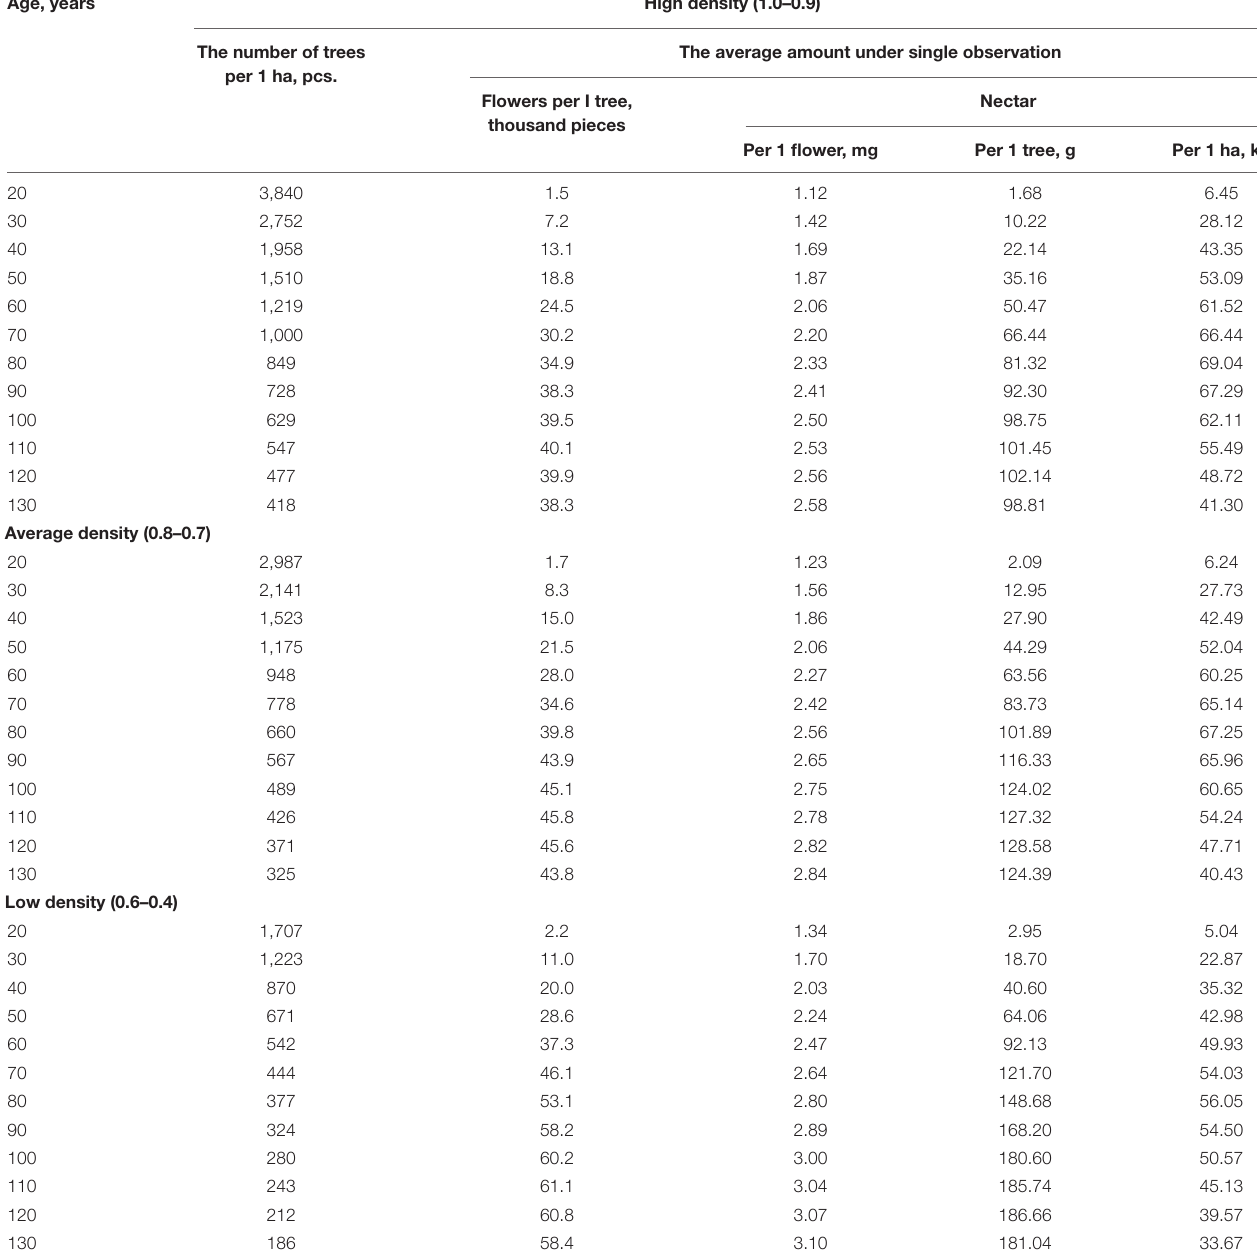
TABLE 1 | Honey productivity of Tilia cordata Mill. depending on the stand density (Murakhtanov, 1977). Age, years High density (1.0–0.9) The number of trees per 1 ha,